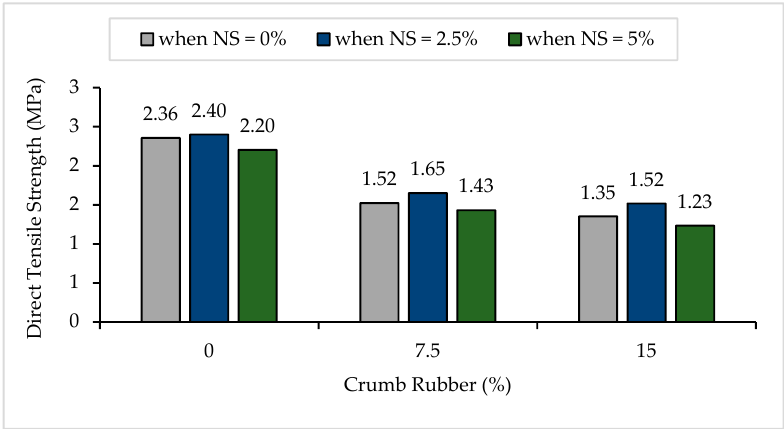
Figure 6 . Direct tensile strength of NS-CRM mixes at 28 days. Figure 6. Direct tensile strength of NS-CRM mixes at 28 days. Conversely, it was observed that the increase in NS from 0% to 2.5% had a posi- tive influence on the direct tensile strength. The strengths increased by 1.9%, 8.3%, and 12.1% between samples having 0% and 2.5% of NS content at 0%, 7.5%, and 15% of CR replacement, respectively. NS enhances the durability, as well as the strength of the mortar mixture because the ultra-fine particles fill the voids of C-S-H structure and provide a more homogenous distribution of hydrated products. Furthermore, NS increases the density [55], reduces porosity, and improves the bond between aggregates and cement matrix [48]. However, it was observed that incorporating 5% of NS into the mixture had caused a slight drop in direct tensile strength for all CR replacements. According to Sobolev et al. [56], a higher percentage of NS replacing cement in the mixture does not lead to an improvement in the strength because of the improper dispersion of NS particles. Due to their high surface energy, the tendency towards agglomeration is high, thus leading to a weak zone created between the cement matrix and aggregates in the mortar. Therefore, it is vital to attain the composite materials with improved